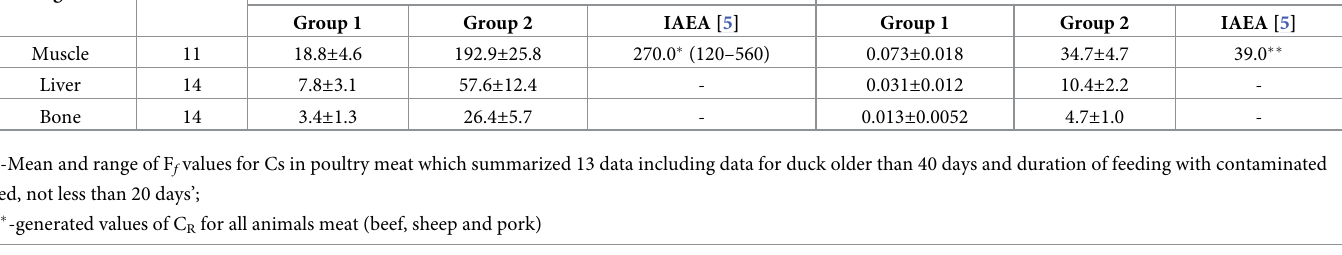
Table 4. Transfer factor and concentration ratio of 137 Cs in broilers’ organs, mean ± SD, 10 − 2 . Organs N